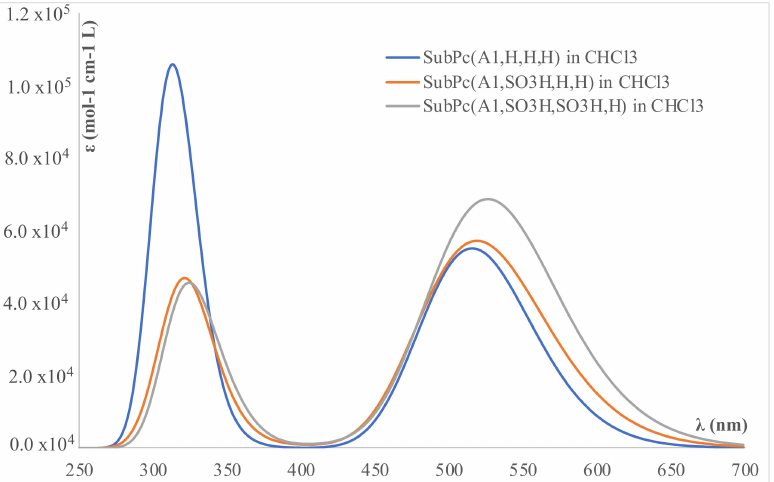
Figure 1. Calculated UV–visible spectra for SubPc(An,R 1 ,R 2 ,R 3 ), with n = 1, 2, 3; R 1 = R 2 = R 3 = H, F, dissolved in CHCl 3 .